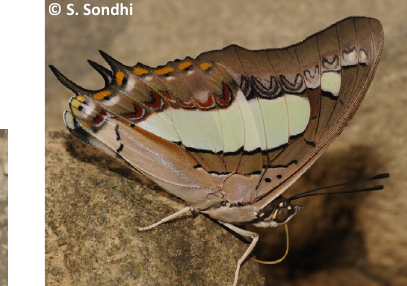
Image 29. Anomalous Nawab Charaxes agrarius agrarius— Saneh, Sonanandi Wildlife